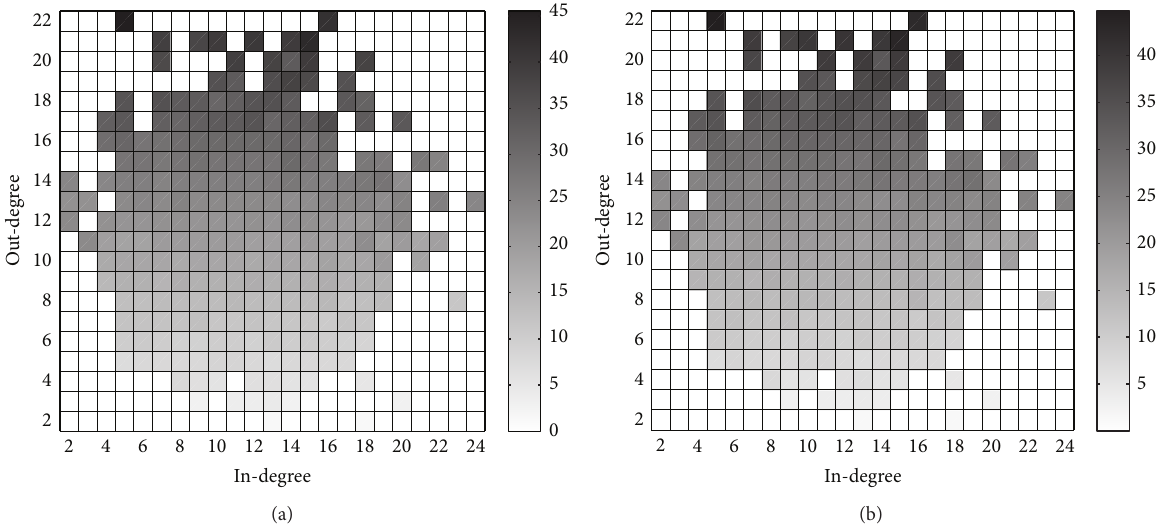
Figure 3: Results for 𝑢 𝑖,𝑗 from (a) simulations and (b) theoretical